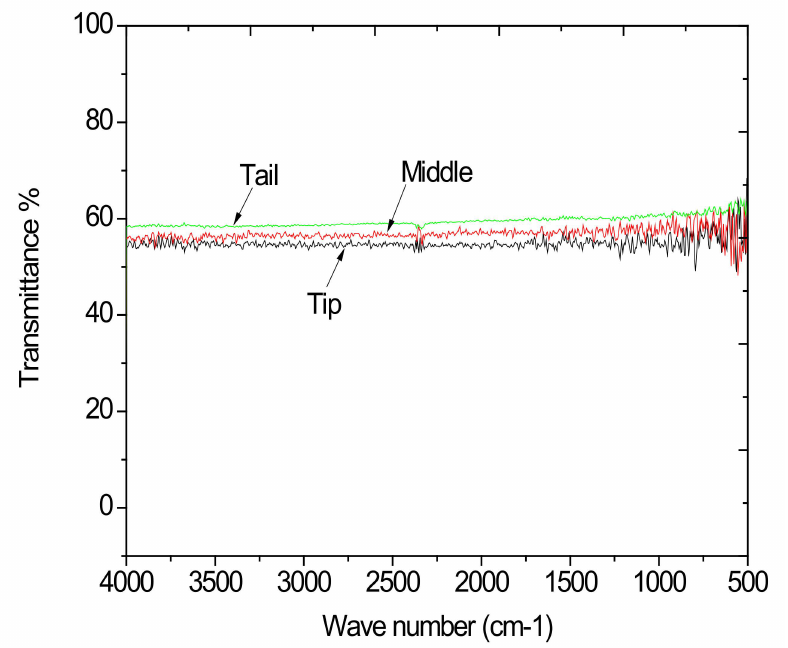
Figure 2. IR Transmittance spectra of co-doped CdZnTe:(In,Pb) of tip, middle and tail wafers at room